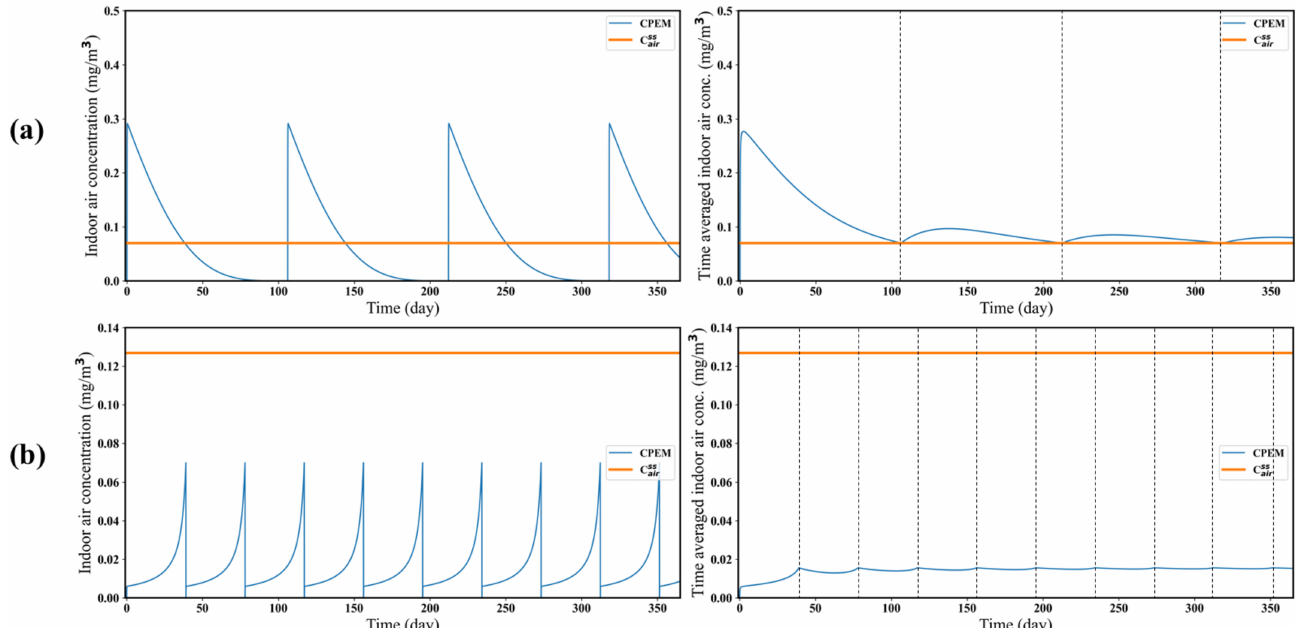
Figure 5. Comparison of the estimated target substance concentrations in the air between the indirect ) and direct estimation method (CPEM). The graphs on the left show the estimation method ( C ss air air concentrations of the target substance at given times, and the graphs on the right show the time-averaged concentration of the target substance in the air over 1 year. The dotted line represents the product exhaustion time. ( a ) When the target substance in a product entirely evaporates until exhaustion time. ( b ) When the target substance in a product does not entirely evaporate until exhaustion